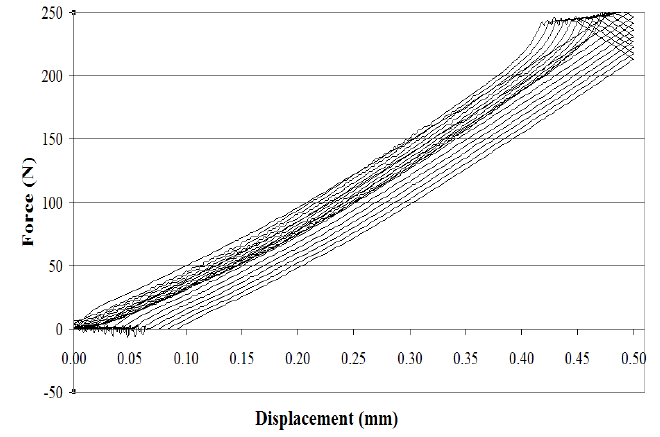
Figure 13. Multicyclic 3-point bending test of glass laminated composite (a) Force- displacement plot; (b) Normalized resistance curves for the two sensors against displacement; (c) Normalized resistance curve for the two sensors against